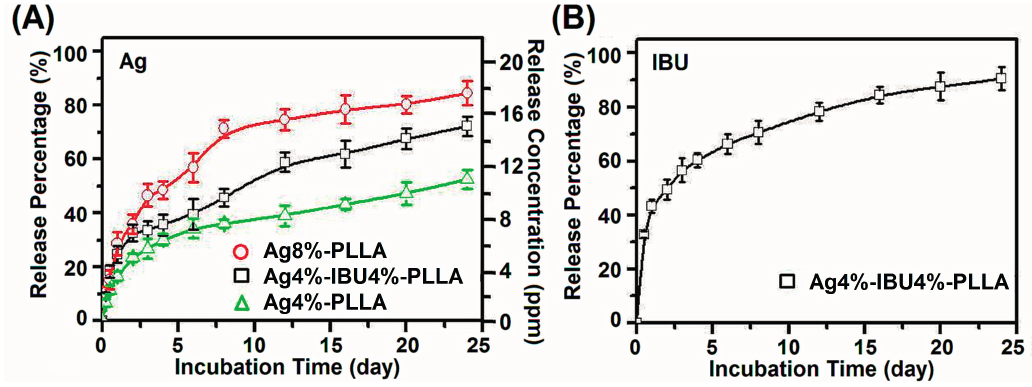
Figure 3. In vitro Ag ion cumulative release percentage and release concentration from Ag4%–PLLA, Ag4%–IBU4%–PLLA and Ag8%–PLLA electrospun fibers ( A ); and IBU release from Ag4%–IBU4%–PLLA electrospun fibers ( B ) after incubating in PBS at 37 °C.